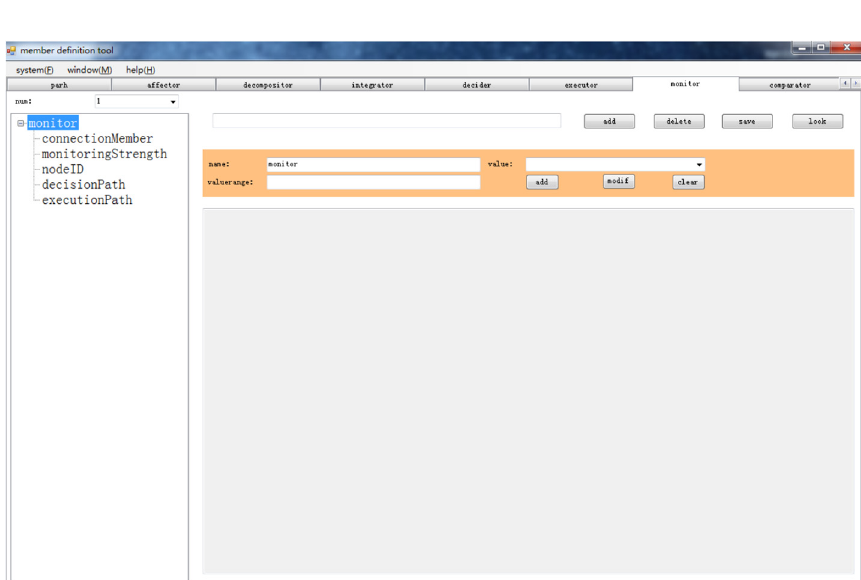
Figure 5. Member general attribute de fi nition interface